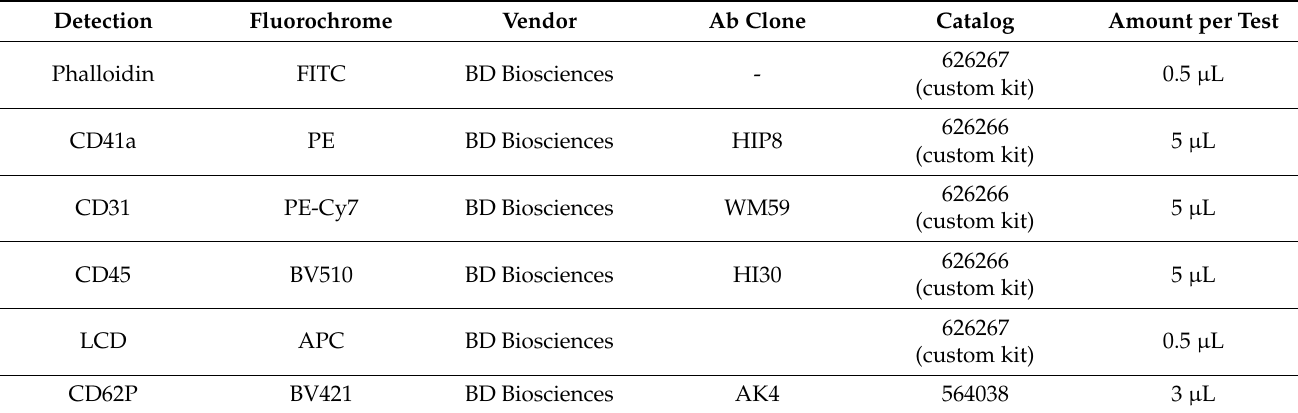
Table 2. List of flow cytometry specificities and